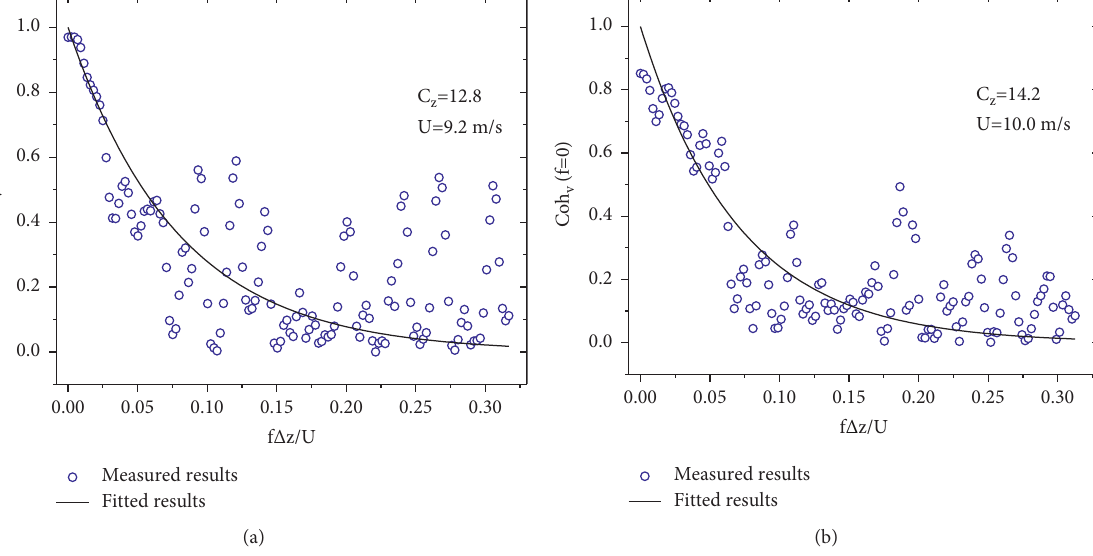
Figure 11: Coherence coefficient curves of the transverse fluctuating wind speed component in different wind speed